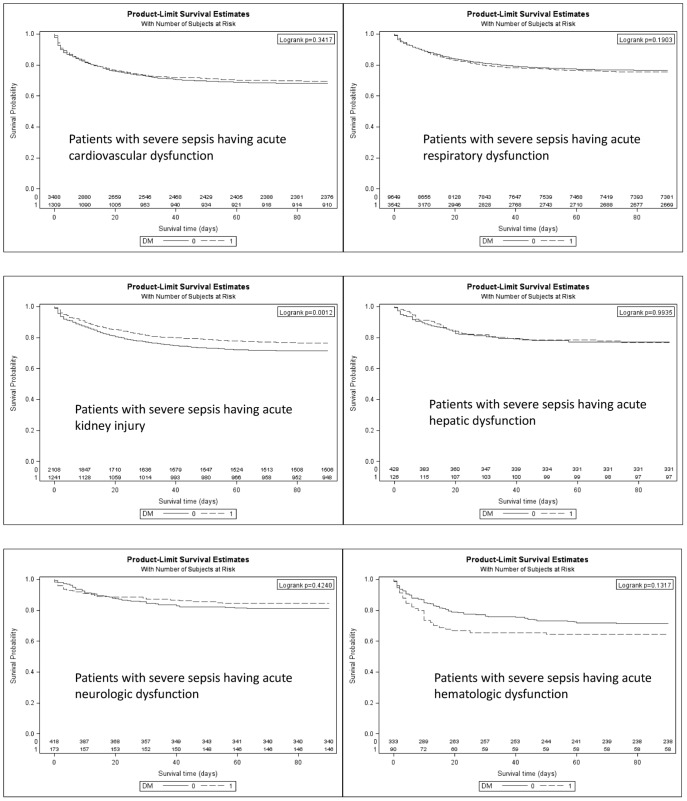
Kaplan-Meier survival curves in diabetic and non-diabetic patients with severe sepsis shown by type of acute organ dysfunction. Log-rank test was used for comparing their survival.